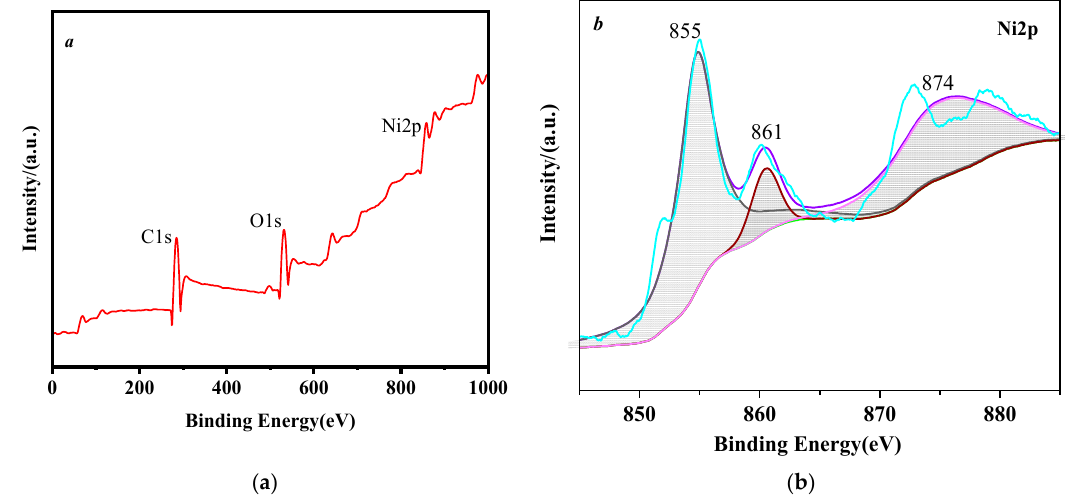
Figure 5. XPS spectra scanning of HTPB/Ni. ( a ) Full–spectrum scanning and ( b ) 2p peak of Ni.